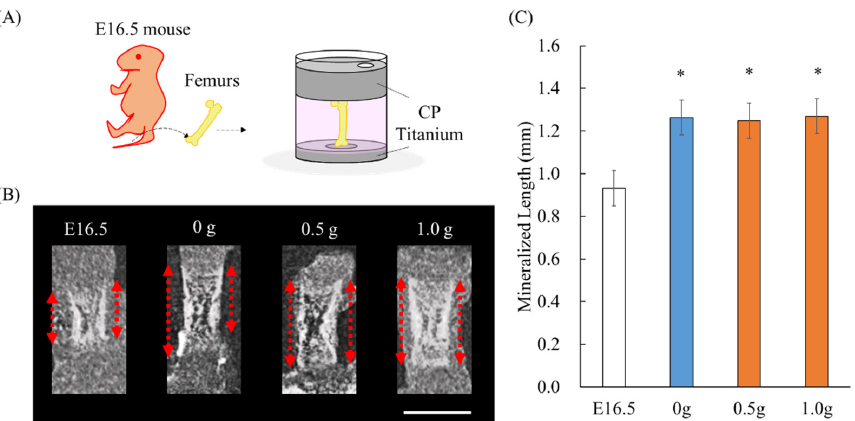
Figure 1. Ex vivo bone culture model and micro-CT analysis: ( A ) Schematic illustration of ex vivo model, ( B ) longitudinal images by micro-CT scanning (red dot line: mineralized length), ( C ) mineralized length of the femur before and after cultivation. Scale bar: 1 mm. * p < 0.05 (vs. E16.5).